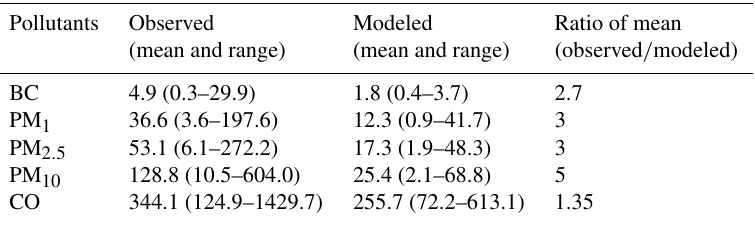
Table 3. Intercomparison of observed and model-simulated hourly average concentrations of air pollutants during the measurement campaign period. Units: BC and PM in µgm − 3 and CO in